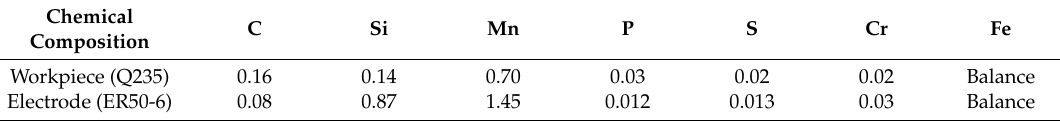
Table 1. Chemical composition (in weight %).